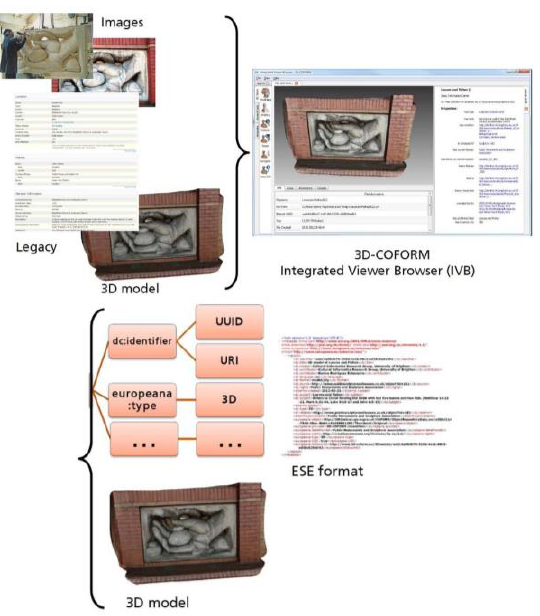
Figure 3: Annotating 3D artefacts with IVB and export to